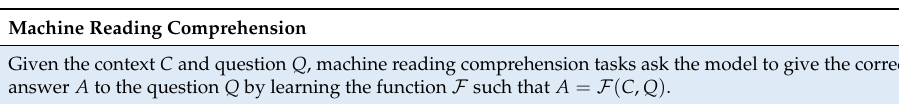
Table 1. Definition of machine reading comprehension.